Question: Identify the chart type used in this figure.
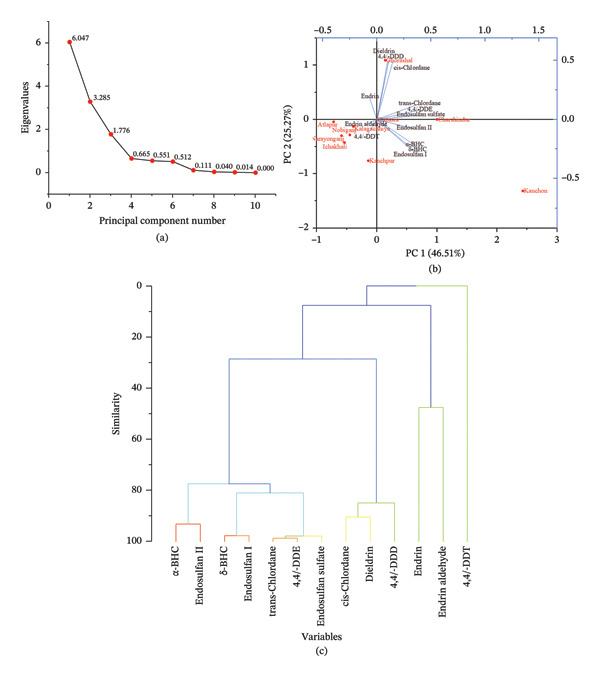
Answer: scatter